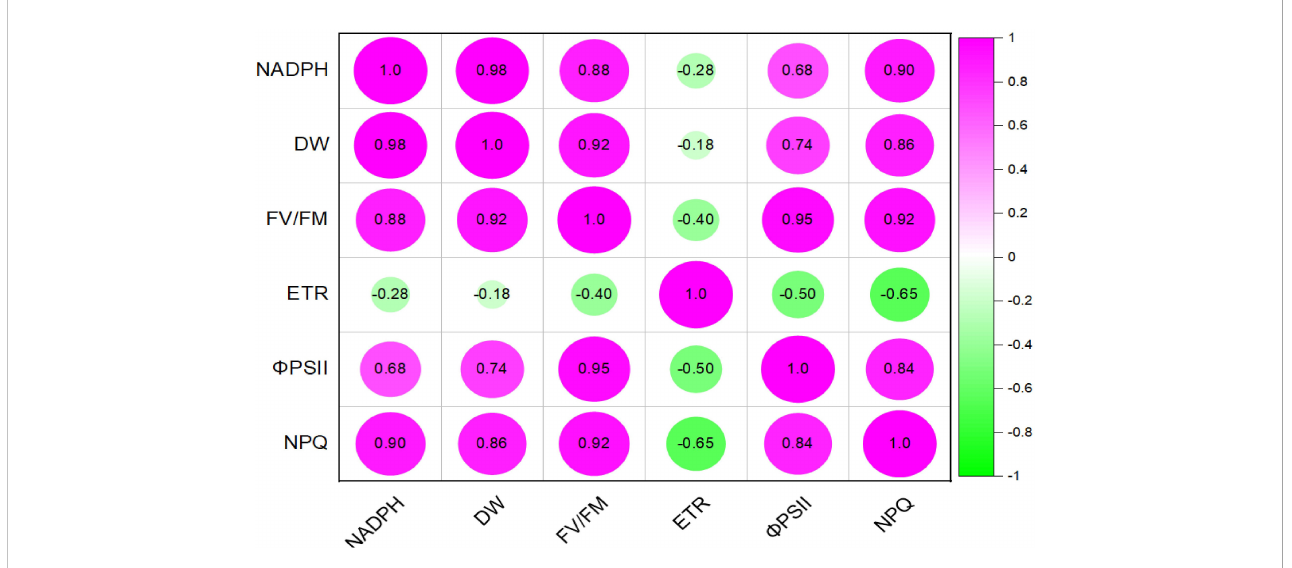
FIGURE 11 pearssons correlation plot of various light response chlorophyll a fl uorence parameters, NADPH and dry matter of mutant Medicago truncatula overexpressing bermudagrass miR171f under saline